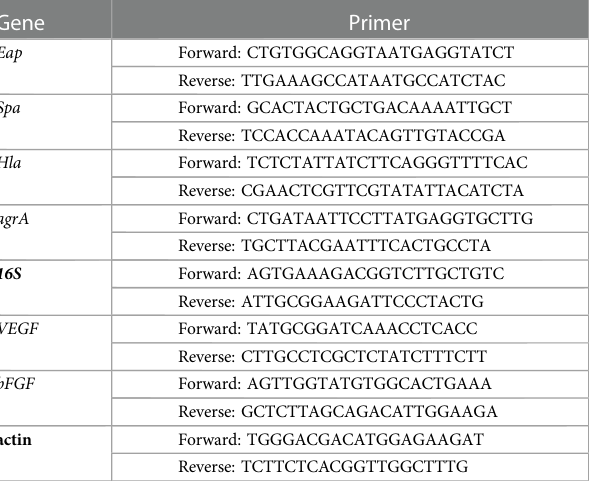
TABLE 1 Primer sequences for quantitative